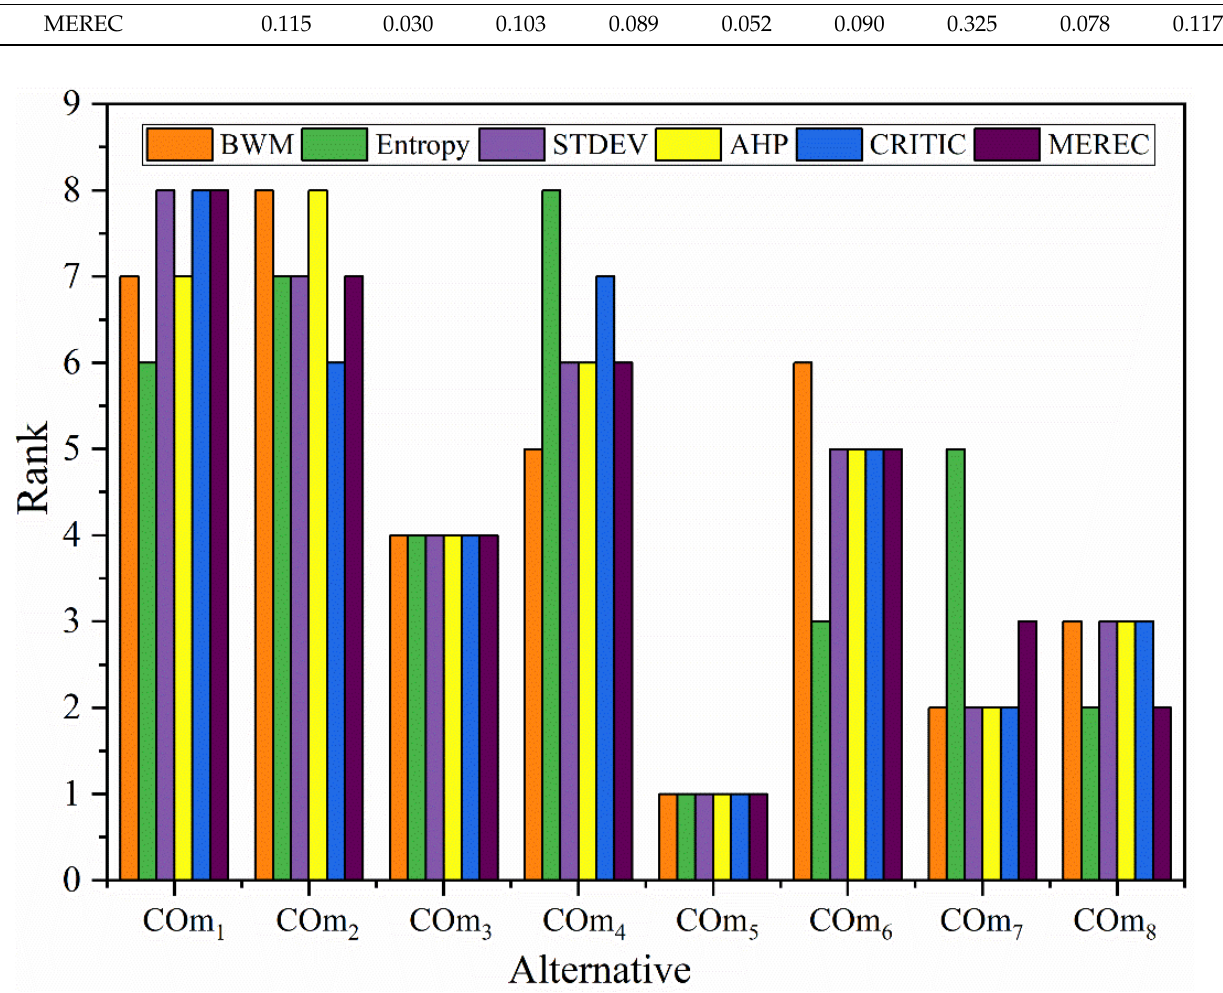
Figure 4. Effect of different criteria weighting methods on the ranking of alternative.